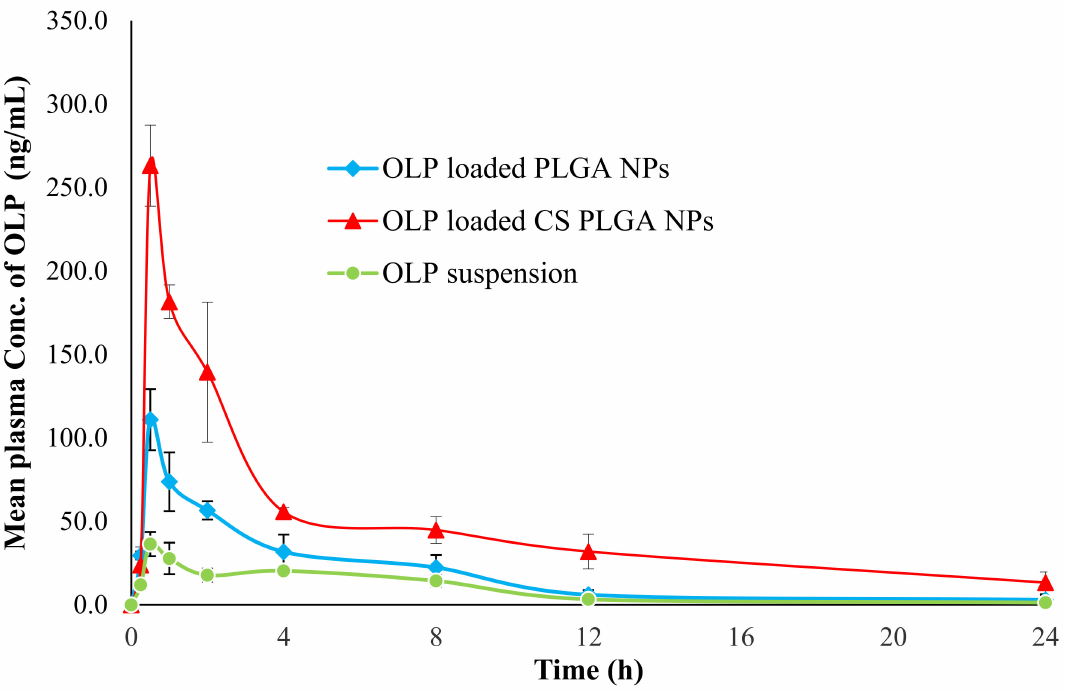
Figure 6. Comparative in vitro pharmacokinetic profile of pure OLP and their developed